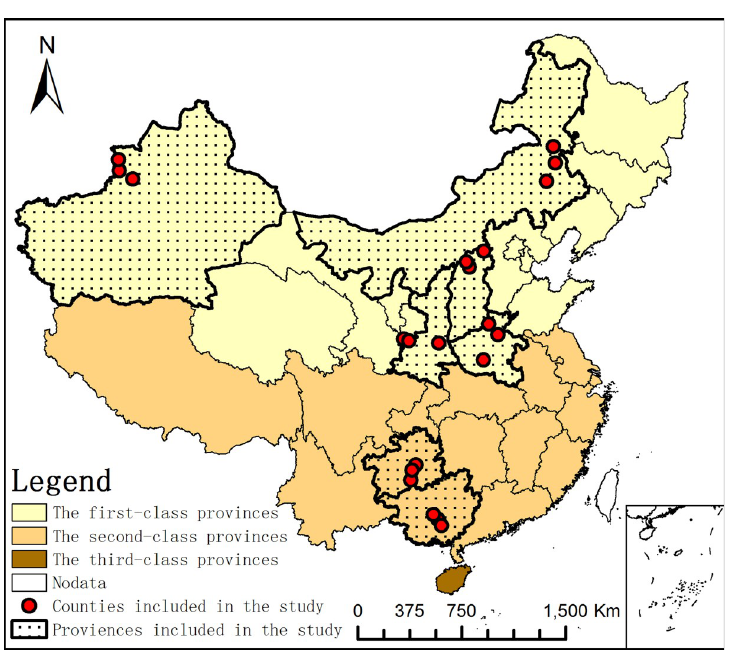
Fig 1. Map of the study area. Vector map file came from Resources and Environment Science Data Center, Chinese Academy of Sciences and was performed with ArcGIS10.4 software (ESRI INC., Redlands, CA, USA).